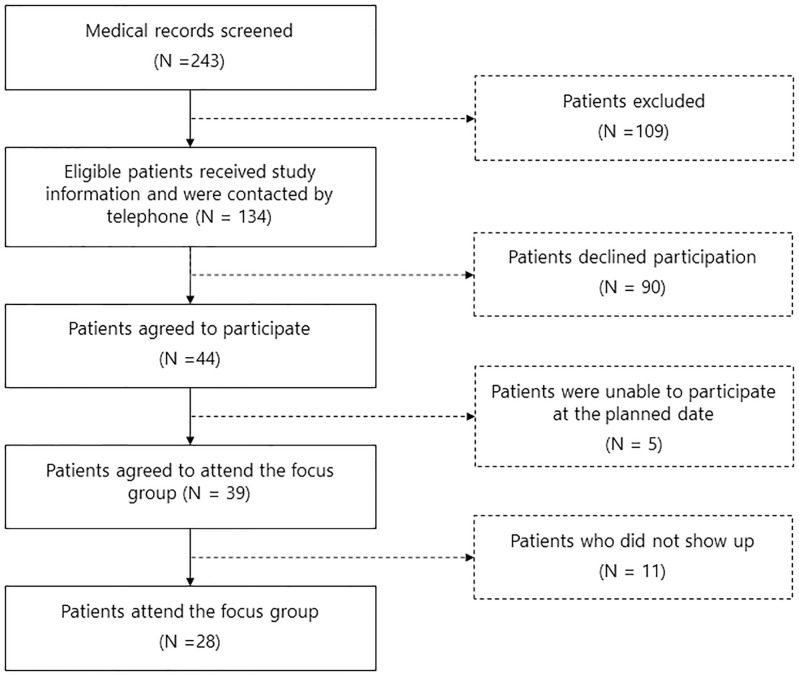
Flowchart of patient inclusion.